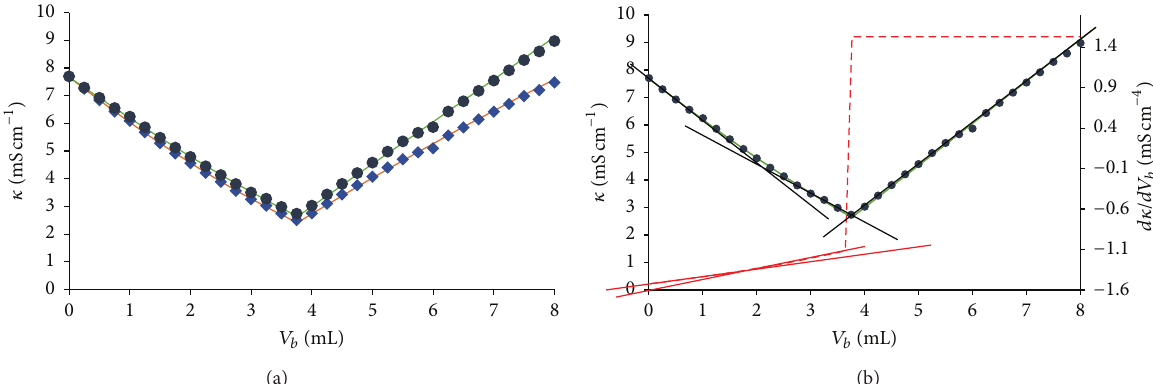
Figure3:Plotsof 𝜅 and 𝜅 asafunctionof 𝑉 𝑏 forthetitrationsystemstatedinFigure 2.(a)Theconductivityplotsofthesystemandcorrected corr = ℎ(𝑉 ) (markers) and estimated with (11) conductivity are different because of the large dilution during titration. (b) Experimental plots 𝜅 𝑏 corr /𝑑𝑉 = ℎ 󸀠 (𝑉 ) ≈ Δ𝜅 /Δ𝑉 and (3) (solid line), and its first derivative, 𝑑𝜅 𝑏 𝑏 𝑏 (segmented line). Auxiliary thin black and red lines are added corr corr to emphasize the linear trends in the corresponding